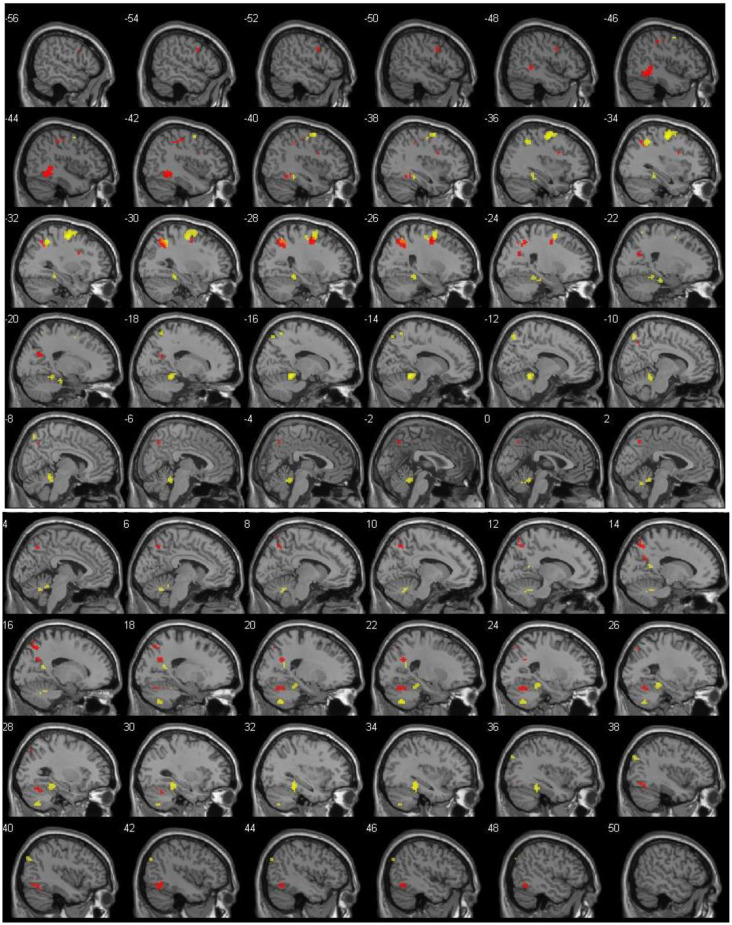
Left (top) and right (bottom) hemisphere activation (p = 0.001, uncorrected), shown with 2-mm spacing between each slice. Value on the top left of each slice shows x coordinate. Red voxels show suprathreshold activation for distance (DIST) condition, whereas yellow voxels stand for direction (DIR) condition. Top left number of each slice indicate MNI x coordinate.